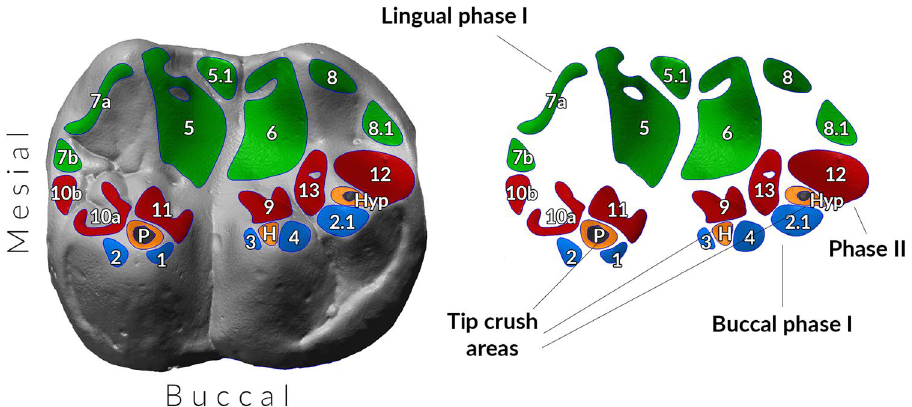
Figure 3. Second right lower molar of a western lowland gorilla adult male (90,194) showing the macrowear pattern. Facets are numbered according to the Maier and Schneck’s labelling system 51 . Buccal phase I (facets 1, 2, 2.1, 3 and 4; in blue), lingual phase I (facets 5, 5.1, 6, 7, 8 and 8.1; in green) and phase II (facets 9, 10, 11, 12 and 13; in red). We also identified tip crush areas (in orange) and dentine exposures (in dark grey). P = protoconid, H = hypoconid, Hyp =